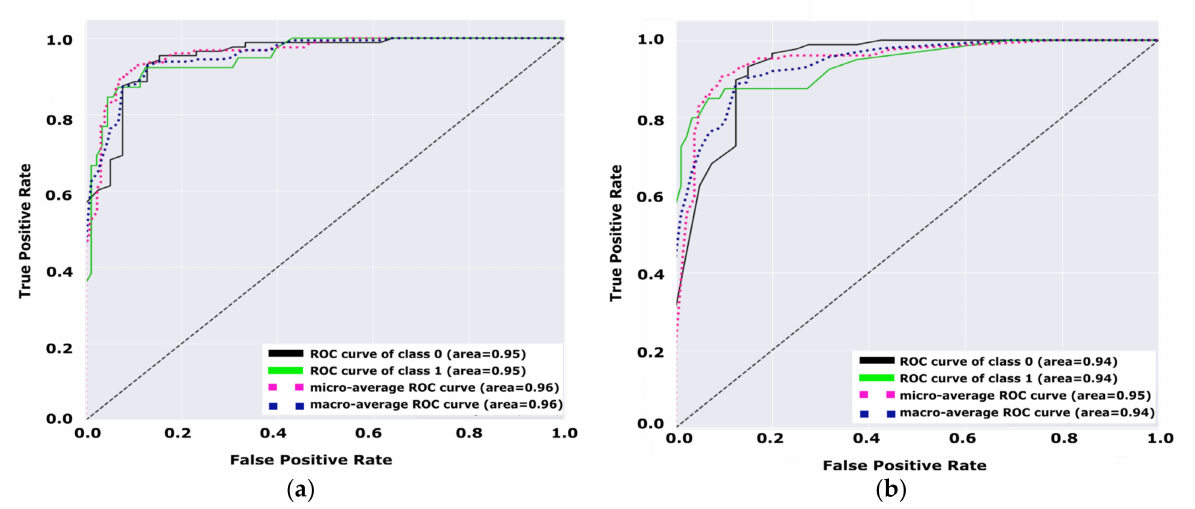
Figure 9. ( a ) ROC curve of the fuzzy KNN classifier for PIDD. ( b ) ROC curve of the TFKNN classifier for